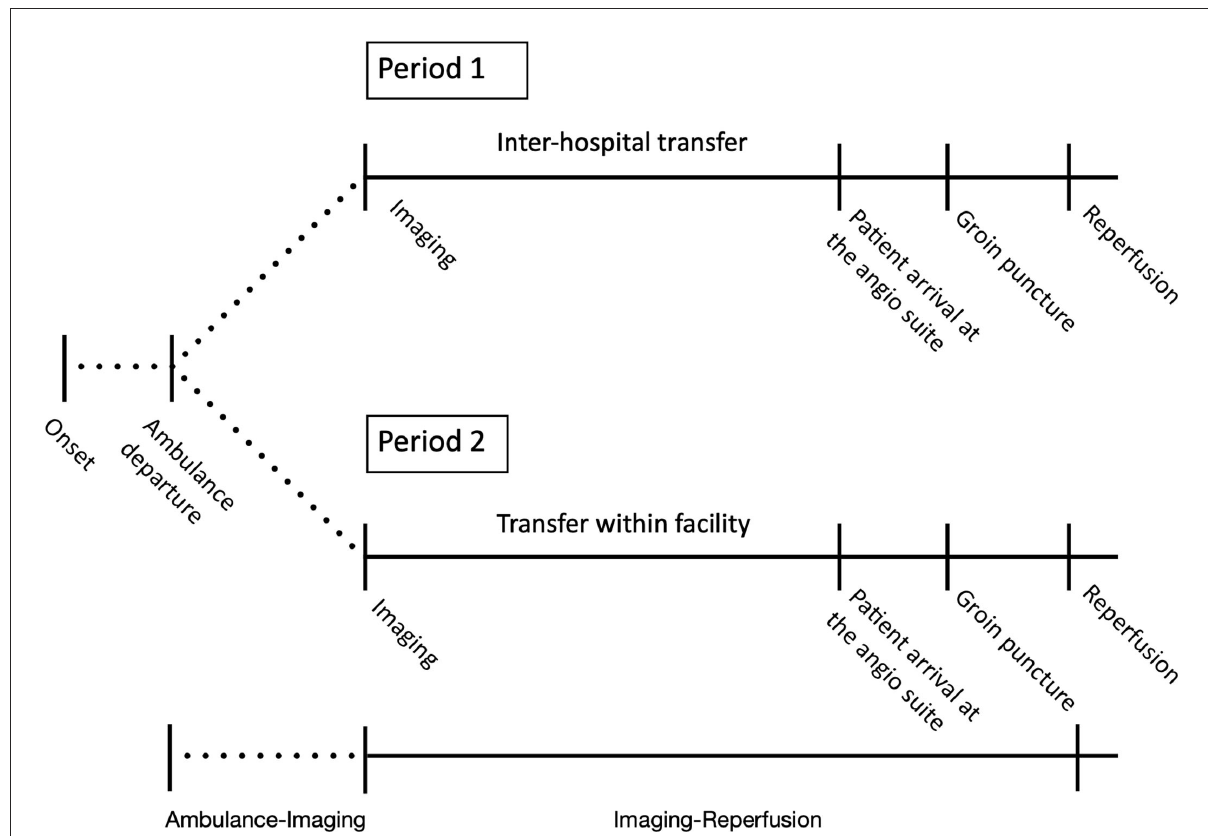
FIGURE1 Changed patient flow following the relocation of IVT services. Period 1 corresponded to before the relocation of the IVT services (1 January 2017–16 April 2018) and period 2 to after the relocation (17 April 2018–31 December 2018). In period 1, IVT services were located at a non-MT center, and in period 2, IVT services were located at an MT-capable center. Time metrics were divided into time from ambulance departure from stroke onset location to first imaging after admission at the first hospital (ambulance-imaging) and from first imaging after admission to reperfusion (imaging-reperfusion). In period 1, imaging-reperfusion included inter-hospital